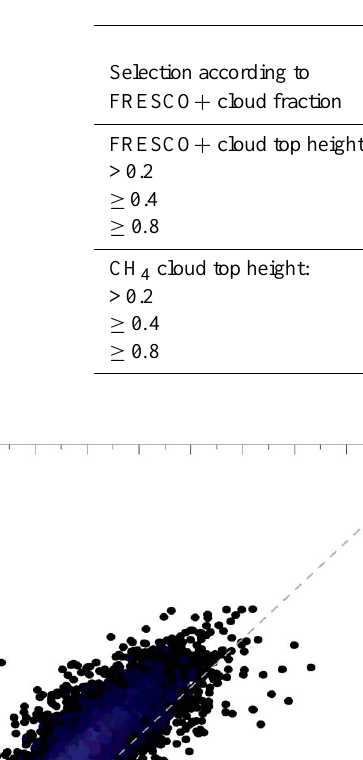
Table 2. Results from comparisons between the (partial) SCIAMACHY-IMLM WVC above the cloud during cloudy conditions over ocean surfaces with partial radiosonde WVC amounts. The partial radiosonde column is obtained by integrating the radiosonde humidity profile from the top of the cloud, where the cloud top height is obtained using either FRESCO + cloud top height (shown in top half of the table) or the cloud top height as estimated from the CH 4 column (shown in bottom half of the table). In both instances the cloud fraction is determined by FRESCO + . The number of cases in selection, mean WVC difference, standard deviation and correlation coefficient are given in each column.